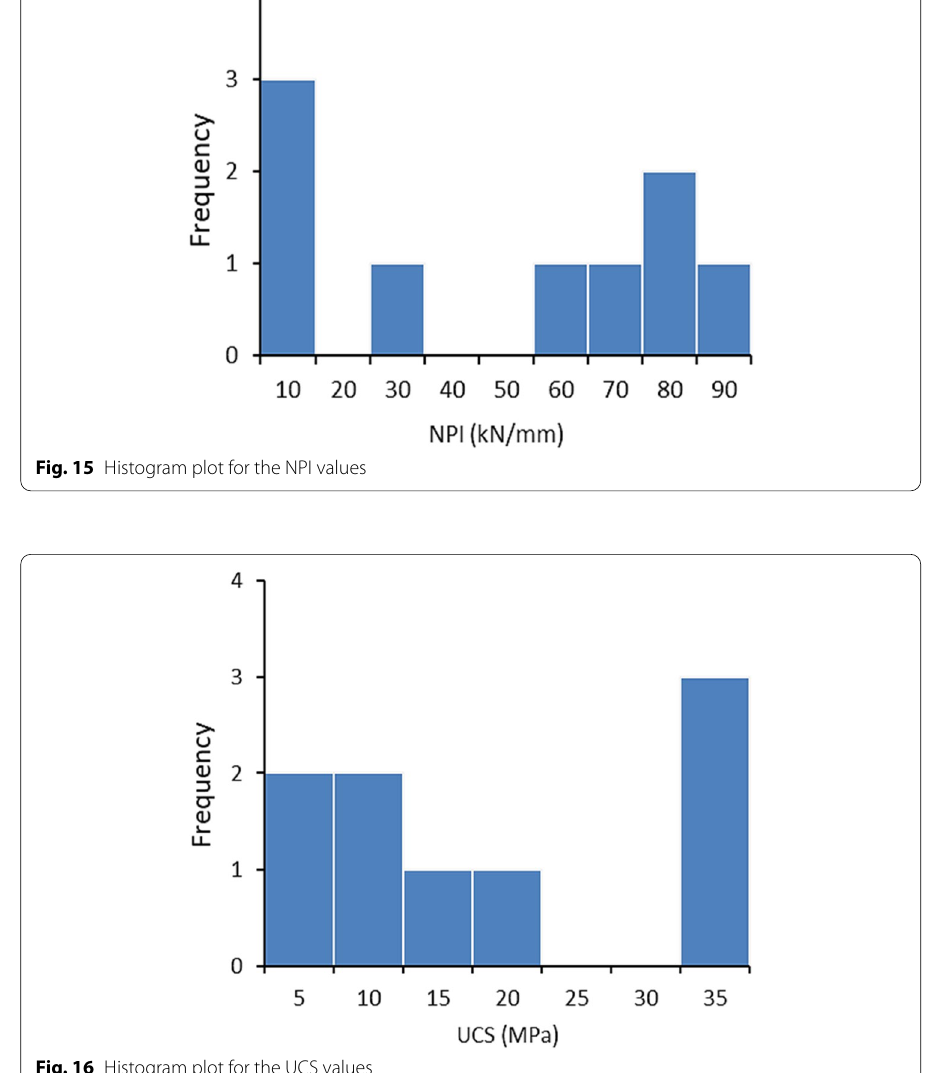
Fig. 16 Histogram plot for the UCS